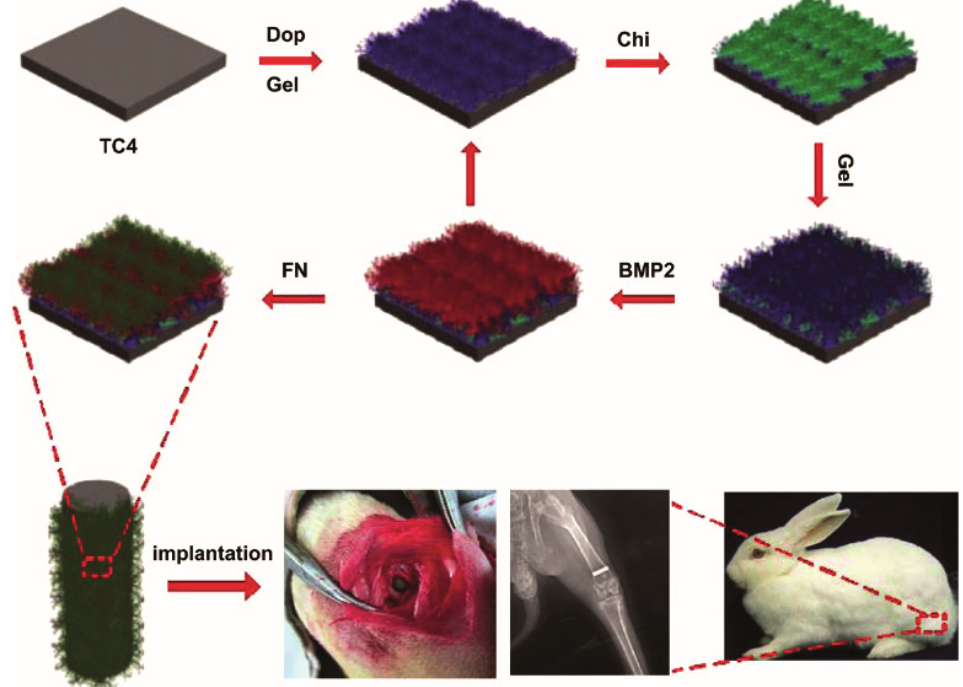
Figure 5. Schematic diagram showing production process of PEM consisting of layers of gelatin (Gel), chitosan (Chi), BMP2 and fibronectin (FN). Titanium alloy Ti6Al4V surfaces (TC4) is first coated with gelatin through dopamine (Dop) conjugation. This is followed by deposition of chitosan, BMP2 and fibronectin layers. Titanium rods coated with these PEM promote osteointegration when inserted into the femur of rabbits.